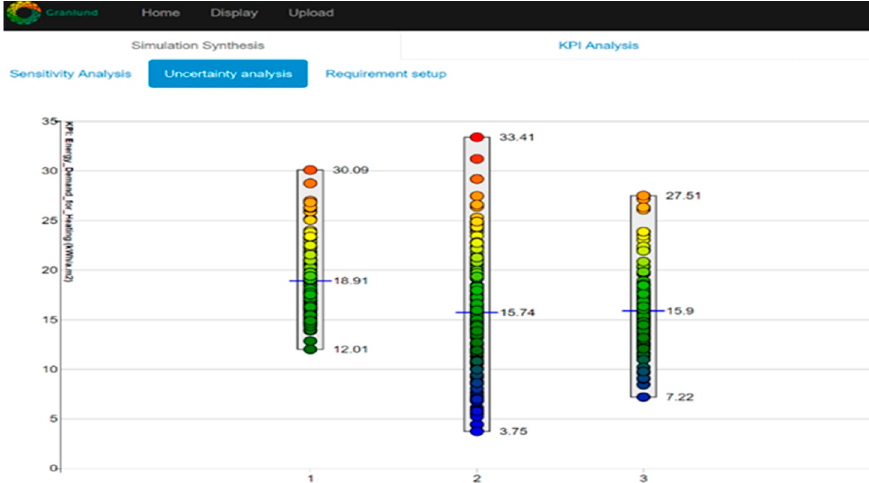
Figure 3. Visualization of simulation results in term of energy demand for heating by three different design variants (Granlund